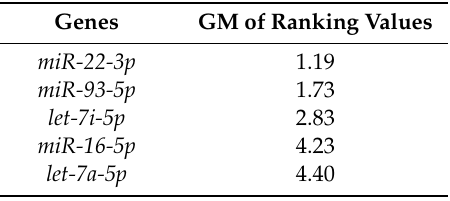
Table 8. Geometric mean ranking values of reference miRNAs assessed by comprehensive ranking methods.